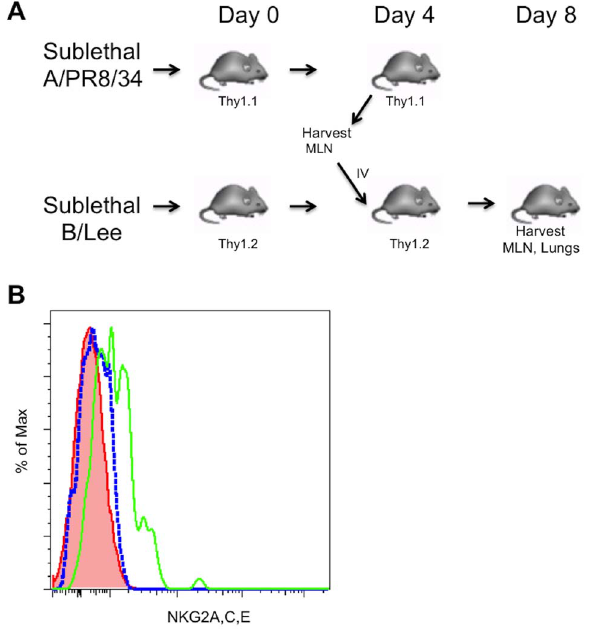
Figure 2. Expression of NKG2A does not require peripheral cognate antigen recognition. A. Donor Influenza A/PR8/34-specific CD8 + T cells isolated from Day 4 p.i. mediastinal lymph nodes were transferred into recipient mice undergoing an irrelevant Influenza B/Lee virus infection on day 4p.i. Cells were isolated from recipient mice at 8 days post influenza B/Lee infection and stained with antibodies for CD90.1 (Thy1.1), CD90.2 (Thy1.2), CD8 and NKG2A. Red area denotes NKG2A expression on recipient CD8 + T cells in the MLN. Blue line denotes NKG2A expression on transferred CD8 + T cells in the MLN. Green line denotes NKG2A expression on transferred CD8 + T cells in the lung. Data represents 3 mice per group pooled. Shown is a representative experiment of at least two independent experiments.